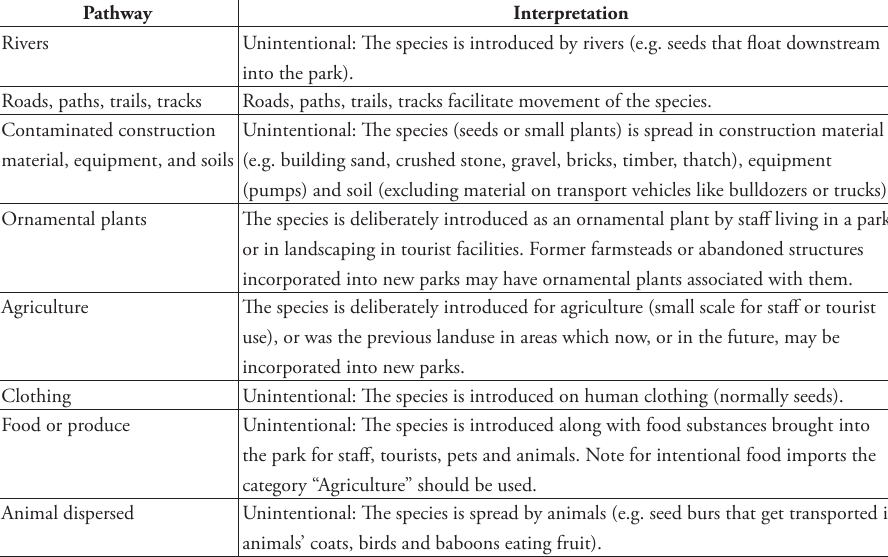
Table 1. Definition and interpretation of pathways of introduction. Pathway